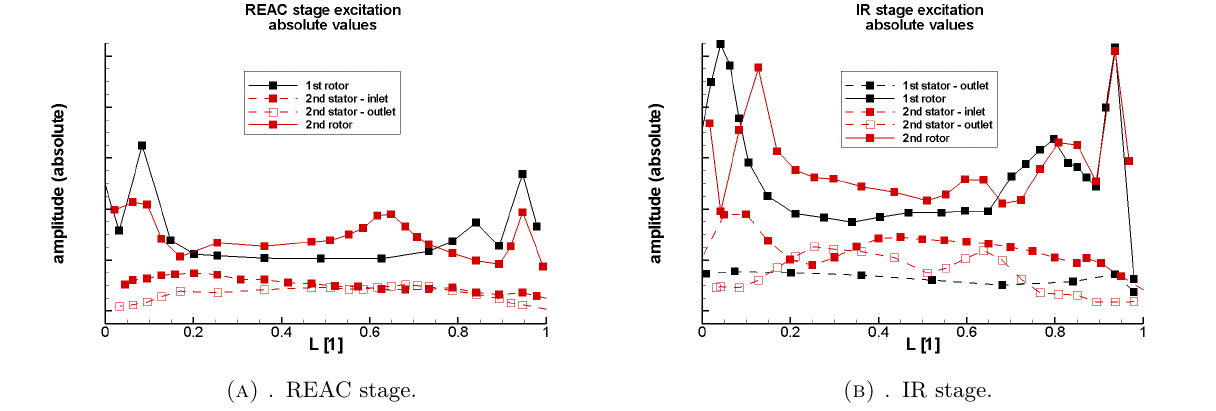
Figure 4. Absolute total pressure amplitudes.